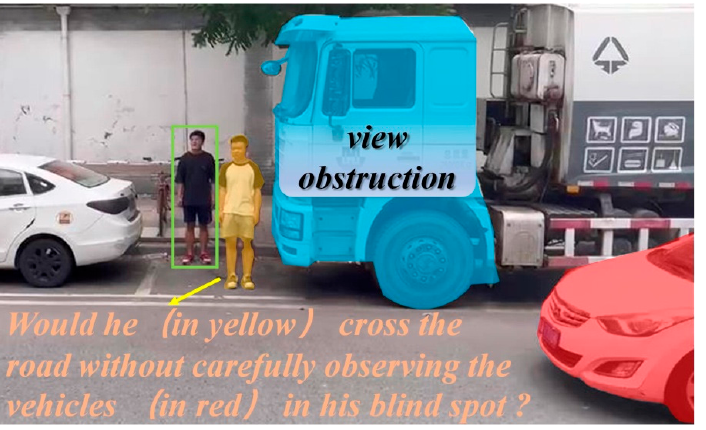
Figure 1. Schematic diagram of hazardous crossing intentions for pedestrians in view-obscured ar-